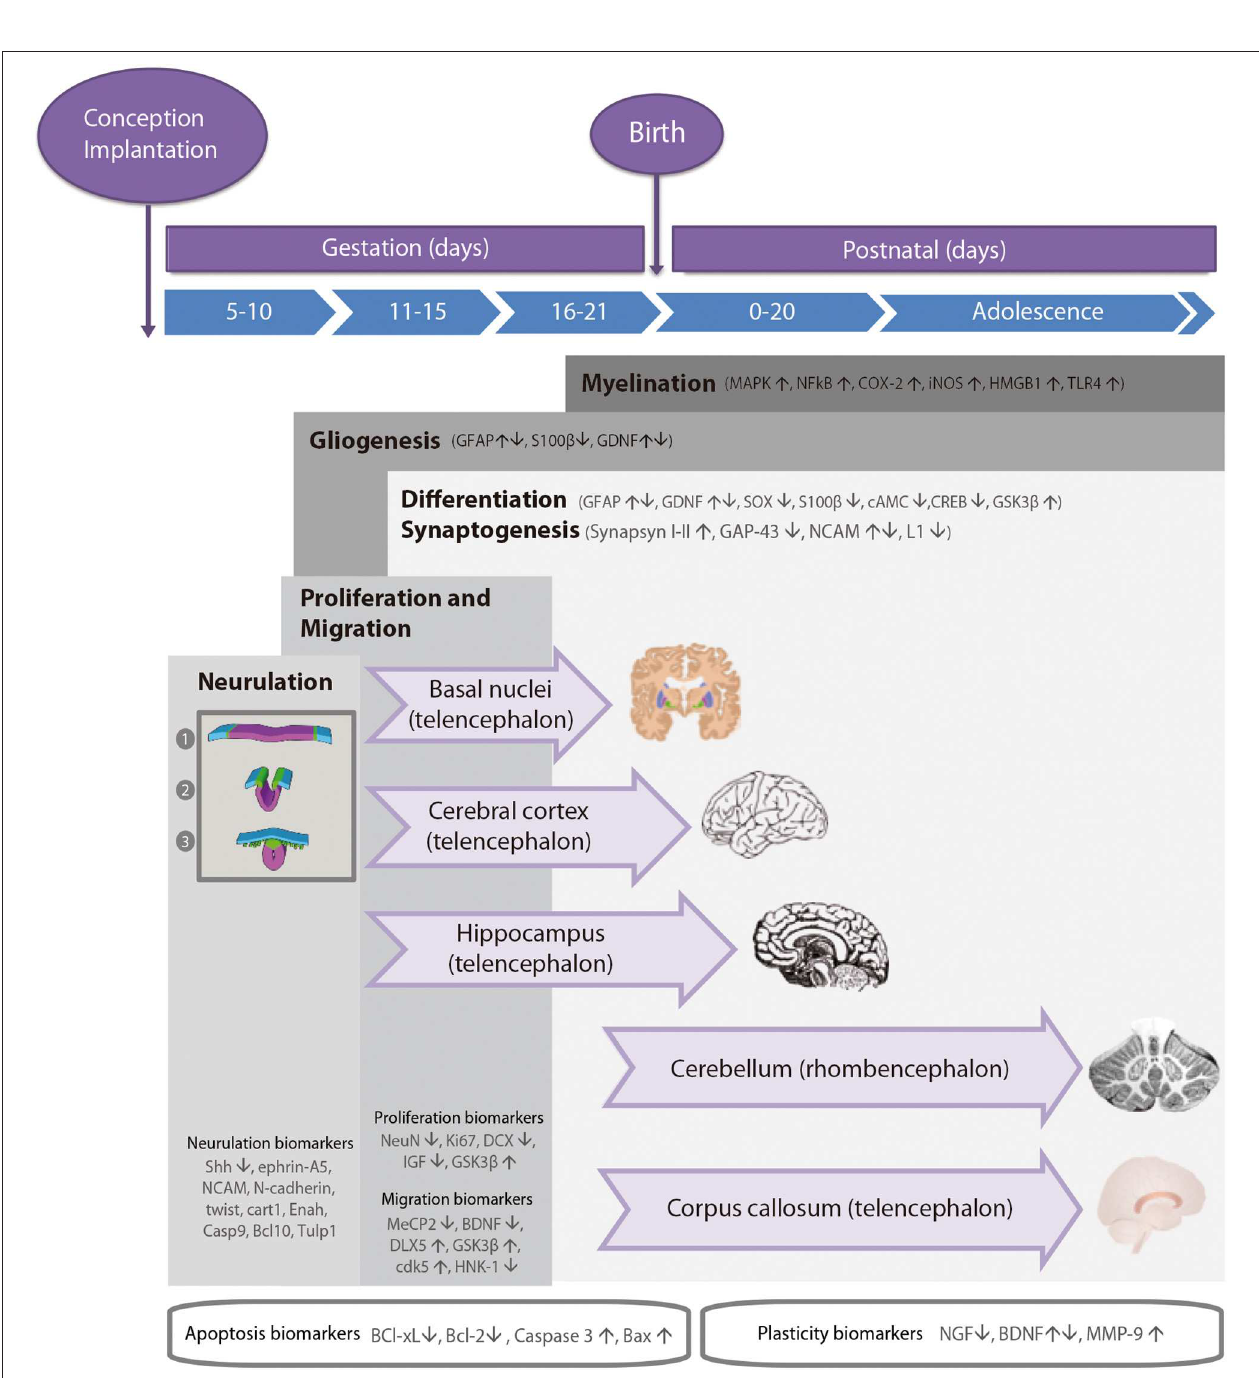
FIGURE 1 | Timeline of neurodevelopmental processes and brain neurogenesis in fetal rodents by areas sensitive to alcohol injury. Proteins in neurulation, proliferation, migration, differentiation, synaptogenesis, gliogenesis, and myelination neurodevelopmental processes. Changes in the levels of these biomarkers (up- or down-regulation) caused by prenatal alcohol exposure are represented by arrows. Stages of neurulation: (1) Neuroectodermal tissues differentiate from the ectoderm and thicken into the neural plate. The neural plate border separates the ectoderm from the neural plate. (2) The neural plate bends dorsally, with the two ends eventually joining at the neural plate borders, forming the neural crest. (3) The closure of the neural tube disconnects the neural crest from the epidermis. Neural crest cells differentiate to form the peripheral nervous system. types involved in the biological stages ( Figure 1 ). Key processes apoptosis (57, 58) are altered by PAE leading to congenital such as proliferation (51), migration (52), differentiation (53), abnormalities and functional deficits in the CNS during fetal synaptogenesis (54, 55), gliogenesis, myelination (56), and development ( Figure 2 ) (74,